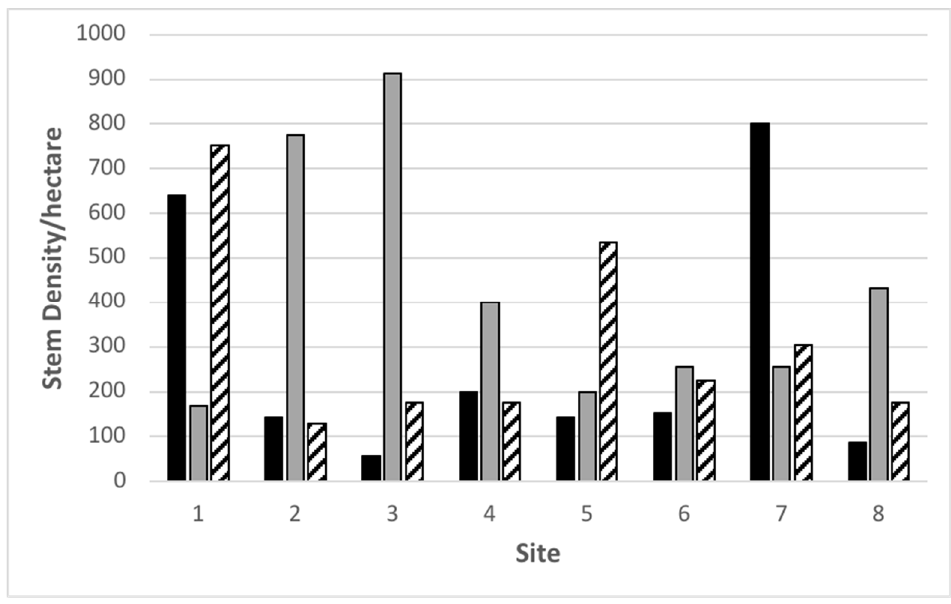
Figure 5. Stem density for the dominant midstory species midstory (black), and the two dominant canopy species Nyssa aquatica (gray) and Taxodium distichum (striped) at Sites 1–8 in 2017.